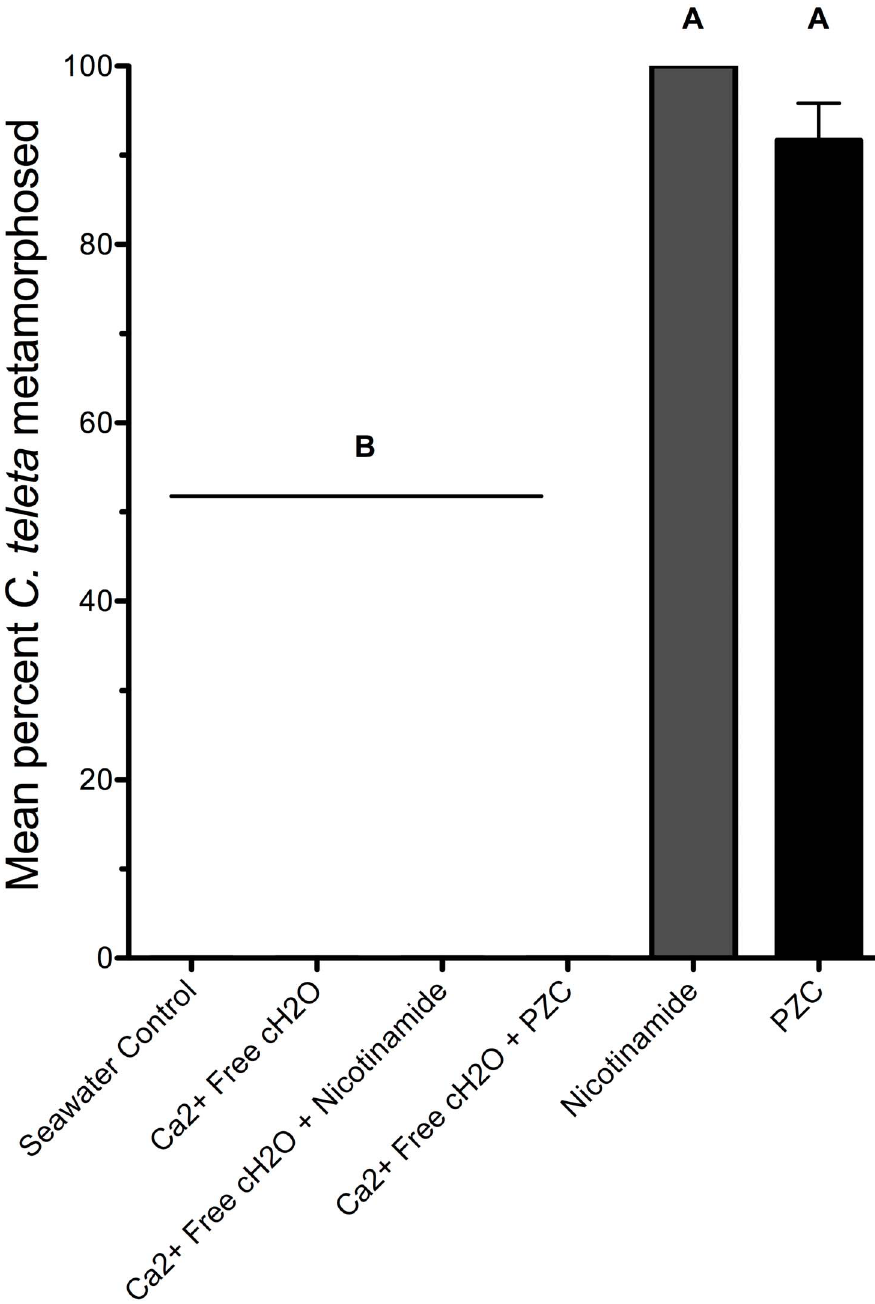
Figure 4. The effect of calcium-free seawater on metamorphosis of C.teleta treated with nicotinamide or pyrazinecarboxamide. Larvae were acclimated to calcium-free seawater for one hour before being transferred to a solution of calcium-free seawater and either nicotinamide or pyrazinecarboxamide (PZC) at 40 m M for 24 h. Each treatment consisted of 3 replicates with 8 larvae per replicate. Artificial seawater (Instant Ocean) acted as a negative control. Letters indicate significant (P , 0.05) differences as determined by a Bonferroni post-hoc test. Error bars represent + 1 s.e.m.